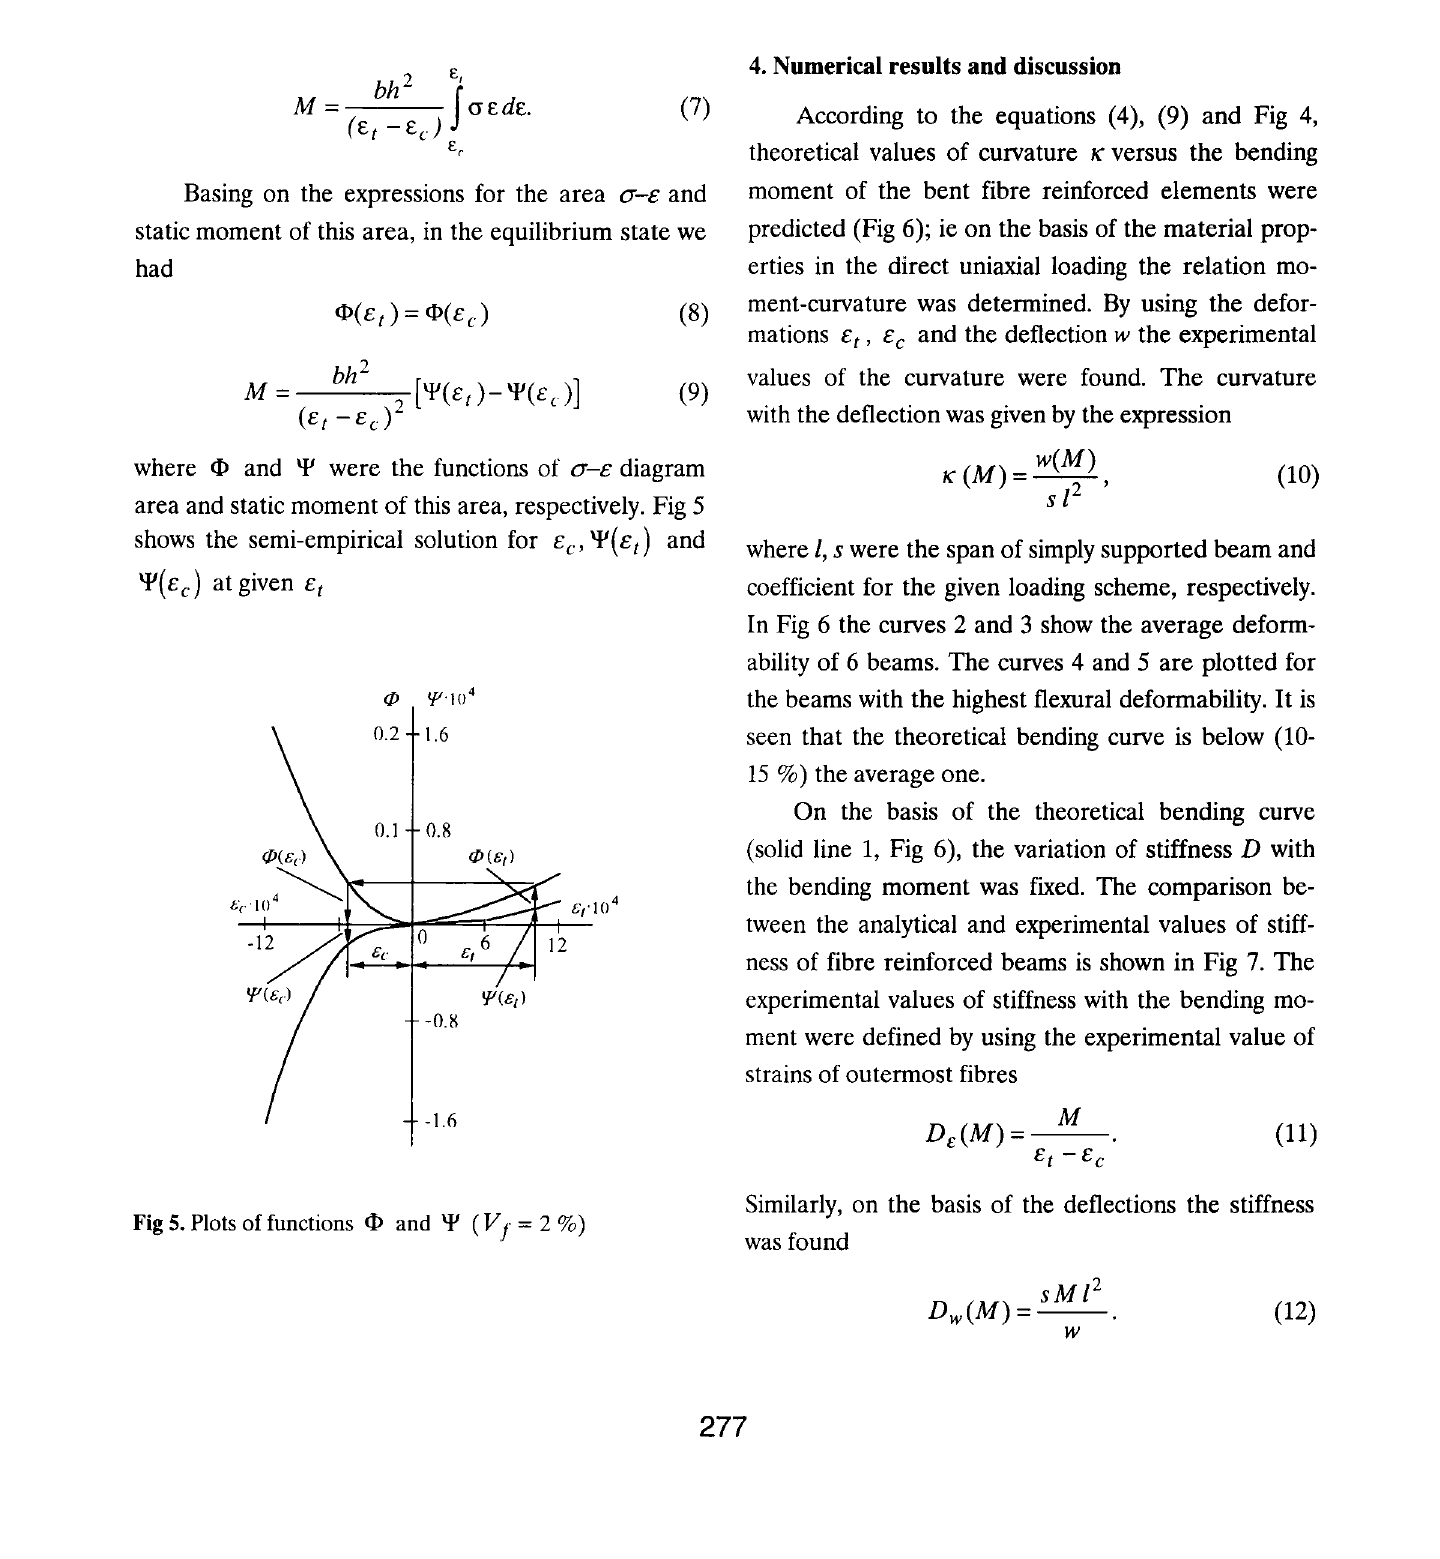
Fig 4. Element of beam in bending and cross-section with axes